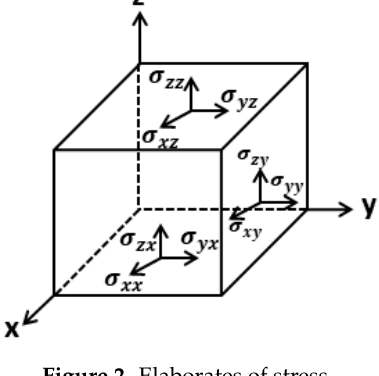
Figure 2. Elaborates of stress.